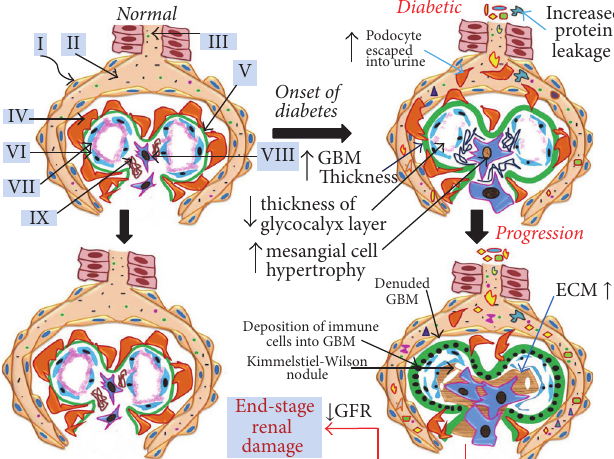
Figure 5: Comparison between normal and diabetic glomeruli with regard to pathological events which occurred during onset and progressionofdiabetes.I,parietalepithelialcells;II,Bowman’scapsule;III,primaryurinemajorlycontainingwater,urea,electrolytes,glucose, and so forth; IV, podocyte; V, glomerular basement membrane (GBM); VI, endothelial cells; VII, glycocalyx layer; VIII, mesangial cells; IX, extracellular matrix (ECM)